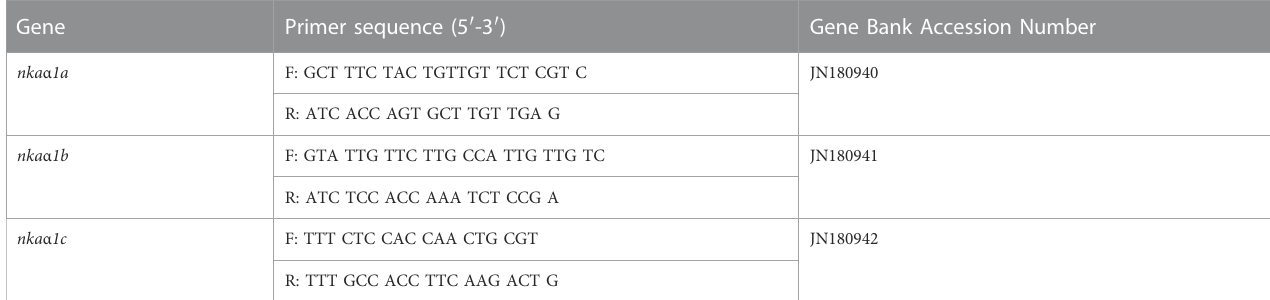
TABLE 1 Primer sequences of nka α 1 subunit used in the assays. Gene Primer sequence (5 ′ -3 ′